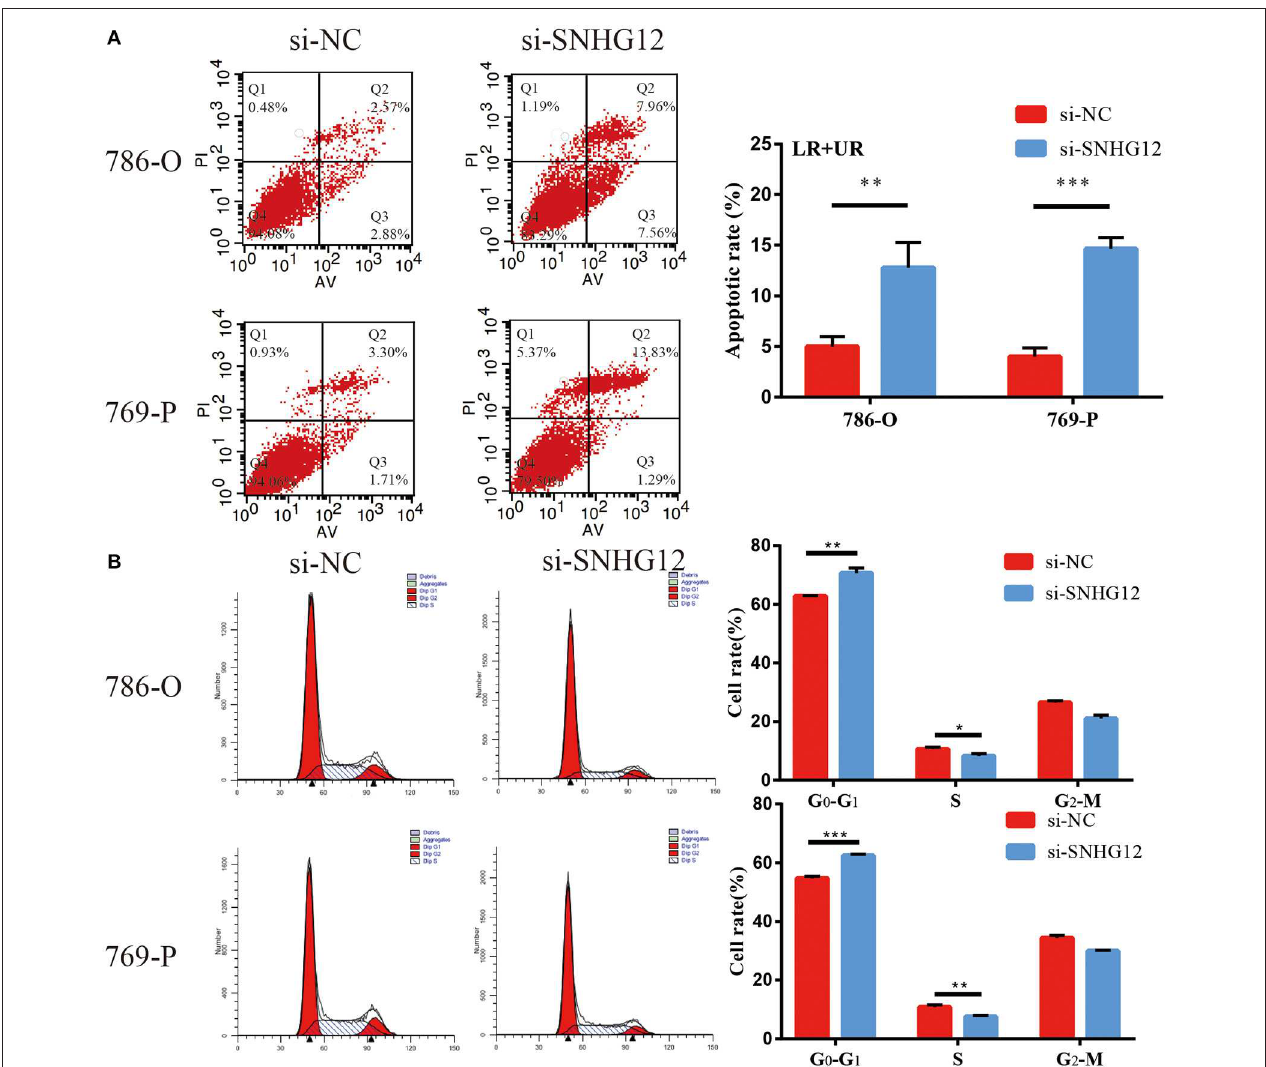
FIGURE 4 | Effects of SNHG12 on ccRCC cells apoptosis and cell cycle. (A) Flow cytometry was used to detect the apoptotic rates (LR + UR) of cells. LR, early apoptotic cells; UR, terminal apoptotic cells. (B) Flow cytometry assay was employed to analyze the cell cycle. Error bars stand for the mean ± SD of at least triplicate experiments. * P < 0.05; ** P < 0.01; *** P <